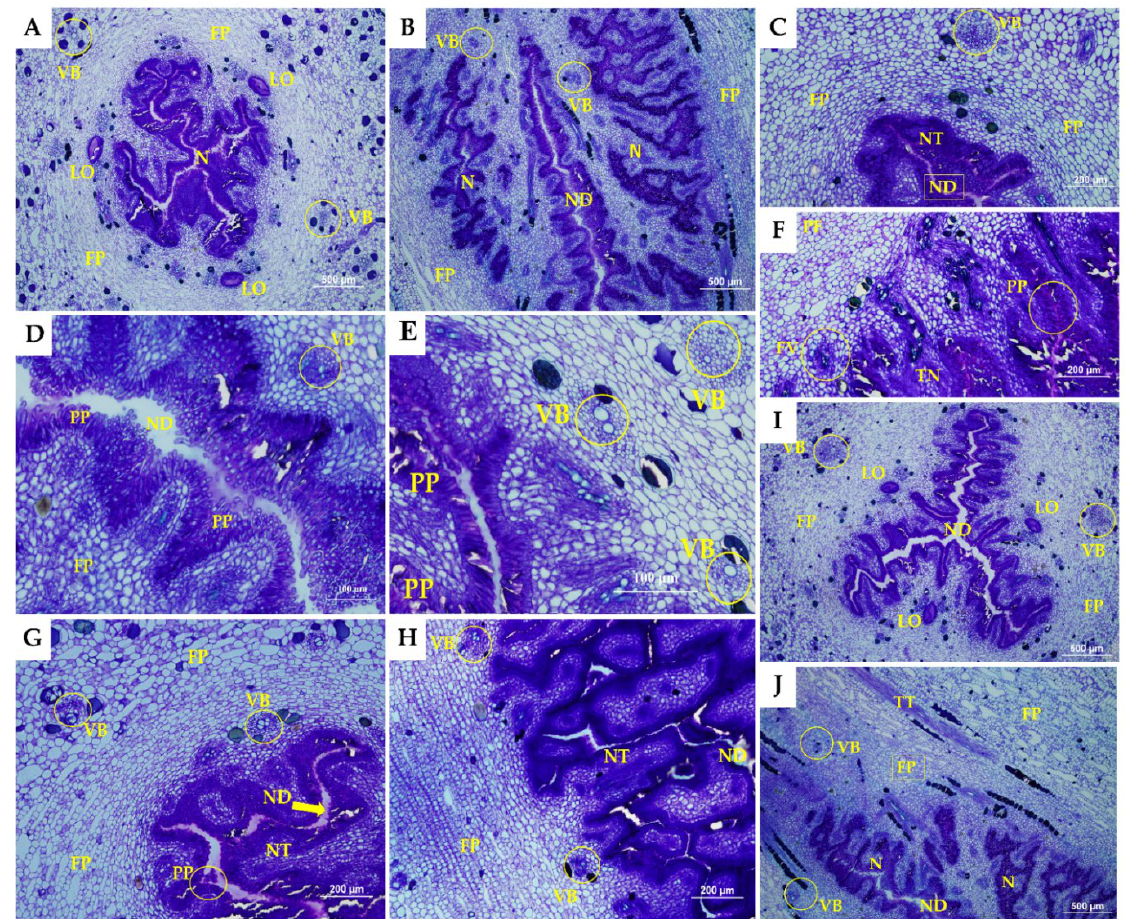
Figure 2. Section of developmental stages of the septal nectaries of Calcutta 4. Longitudinal sections: ( A , C , E , G , I ). Cross-sectional sections: ( B , D , F , H , J ). ND, nectariferous duct; VB, vascular bundle; LO, loculus; N, nectary; FP, fundamental parenchyma; PP, pluristratified papillae; NT, nectariferous tissue; TT, transmitting tissue. The white bars represent 100 µ m ( D , E ), 200 µ m ( C , F – H ), and 500 µ m ( A , B , I , J